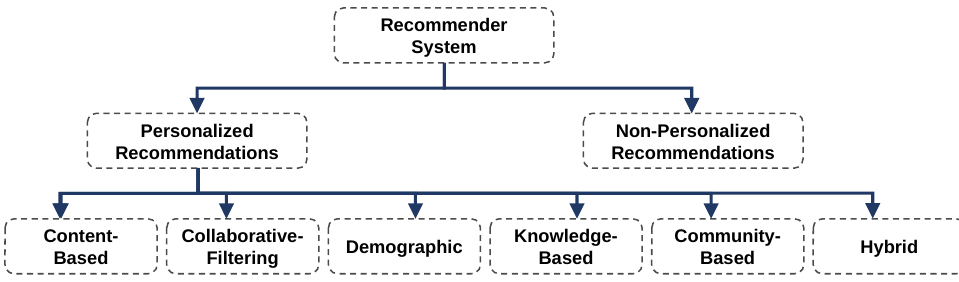
Figure 5. Taxonomy of Recommender Systems